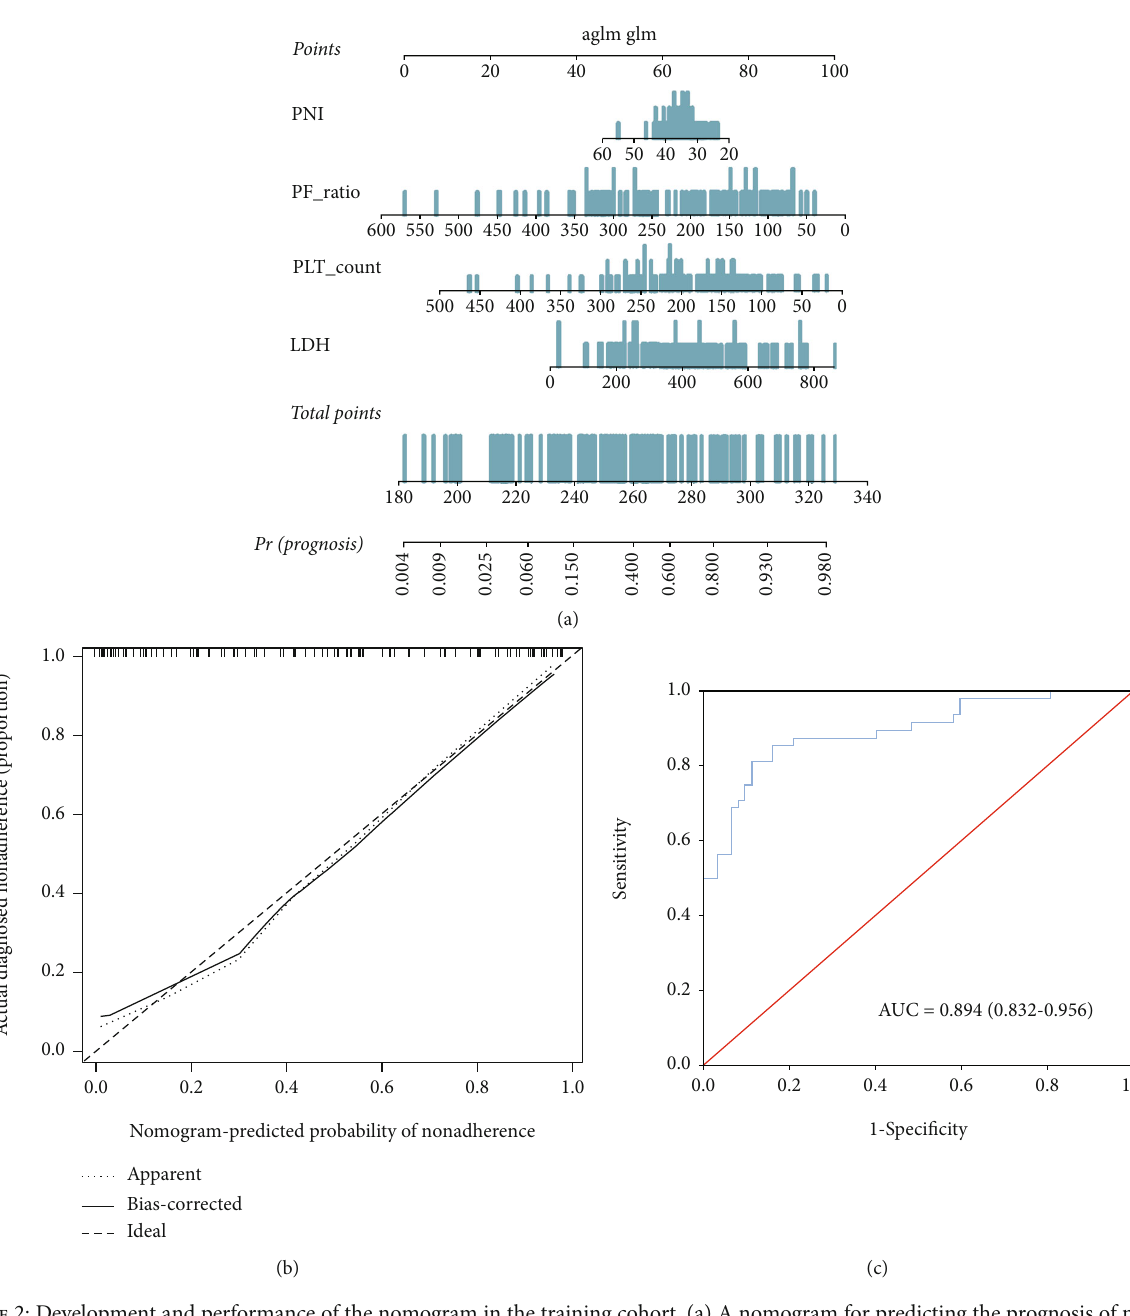
Figure 2: Development and performance of the nomogram in the training cohort. (a) A nomogram for predicting the prognosis of patients with severe COVID-19; (b) calibration curve of the nomogram in the training cohort, which depicts the calibration of the nomogram in terms of the agreement between the predicted risk of death and observed outcomes. The 45 ° dotted line represents an ideal prediction, and the solid line represents the bias-corrected predictive performance of the nomogram. The closer the solid line fi ts the ideal line, the better the predictive accuracy of the nomogram; (c) ROC curve of the nomogram in the training